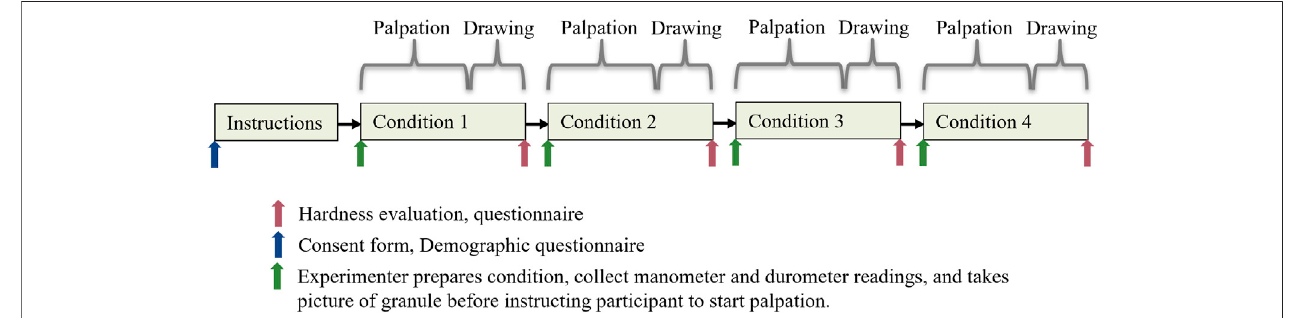
FIGURE 7 | Experimental procedure timeline. The order of the conditions was randomized.